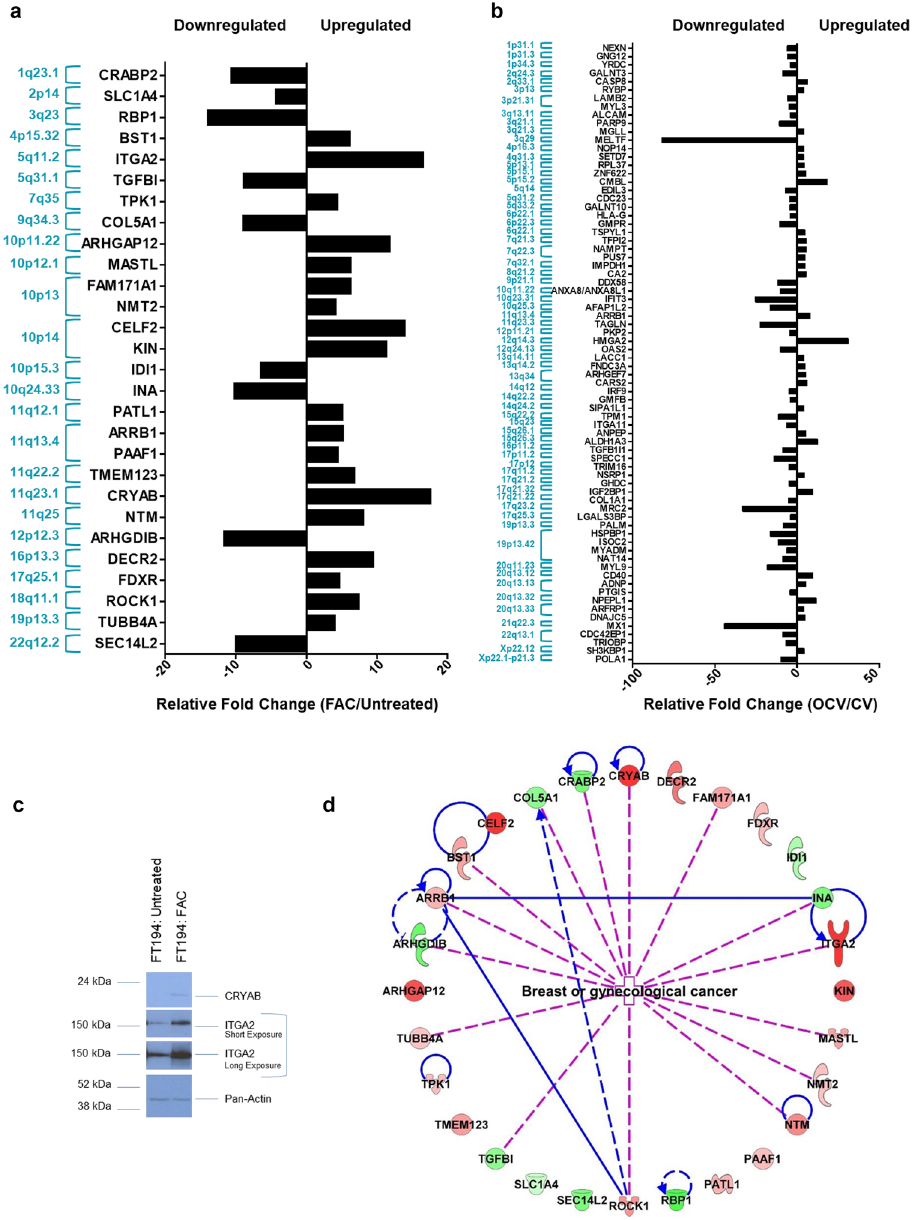
Figure 4. Protein targets and their genomic locations associated with top miRNAs altered in FT194 cells. These graphs show the protein targets associated with highly dysregulated miRNAs in FT194 cells, as determined by IPA analysis. Protein targets with > fourfold change, corresponding to the miRNAs, were compiled and organized by their genomic locations. Relative fold change of these protein targets has been represented for ( a ) 250 nM FAC-treated FT194 cells compared to Untreated, and ( b ) transformed OCV cells compared to CV cells. ( c ) Western Blotting analysis of 250 nM FAC-exposed and Untreated FT194 cells, using cell lysates collected at day 170 of FAC treatment ( p = 52). Three independent replicates were performed; representative cropped blots are displayed. White space between cropped blots delineate different antibody applications to the same blot. The full-length uncropped blots are displayed in the Supplementary Information File. ( d ) Top 28 protein targets altered in gynecological cancers, with > fourfold change, identified for 250 nM FAC-treated FT194 cells compared to Untreated. Upregulated proteins are shown in red and downregulated proteins in green, ranging color intensity based on the fold change associated with each. The detailed legend for all molecular processes in the protein network is included in tabular form in supplementary Fig.